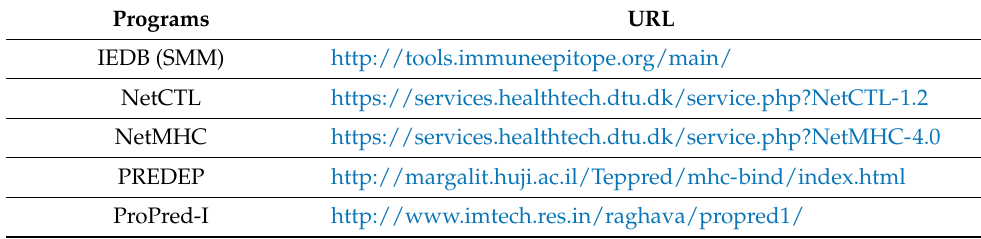
Table 1. Programs used in this study for H-2 d -restricted cluster of differentiation (CD8) + T-cell epitope